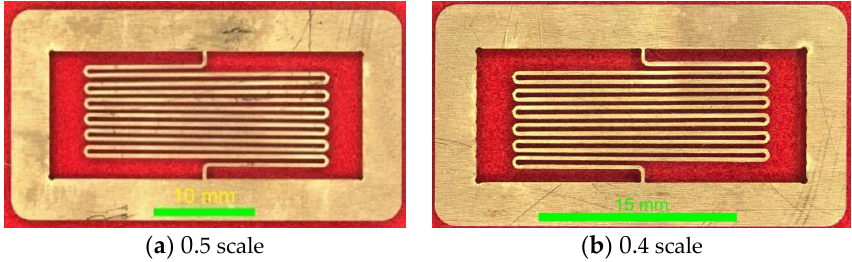
Figure 7.  AWJ-cut 0.5 and 0.4 scales stainless steel flexures (0.58 mm thick). Figure 7. µ AWJ-cut 0.5 and 0.4 scales stainless steel flexures (0.58 mm